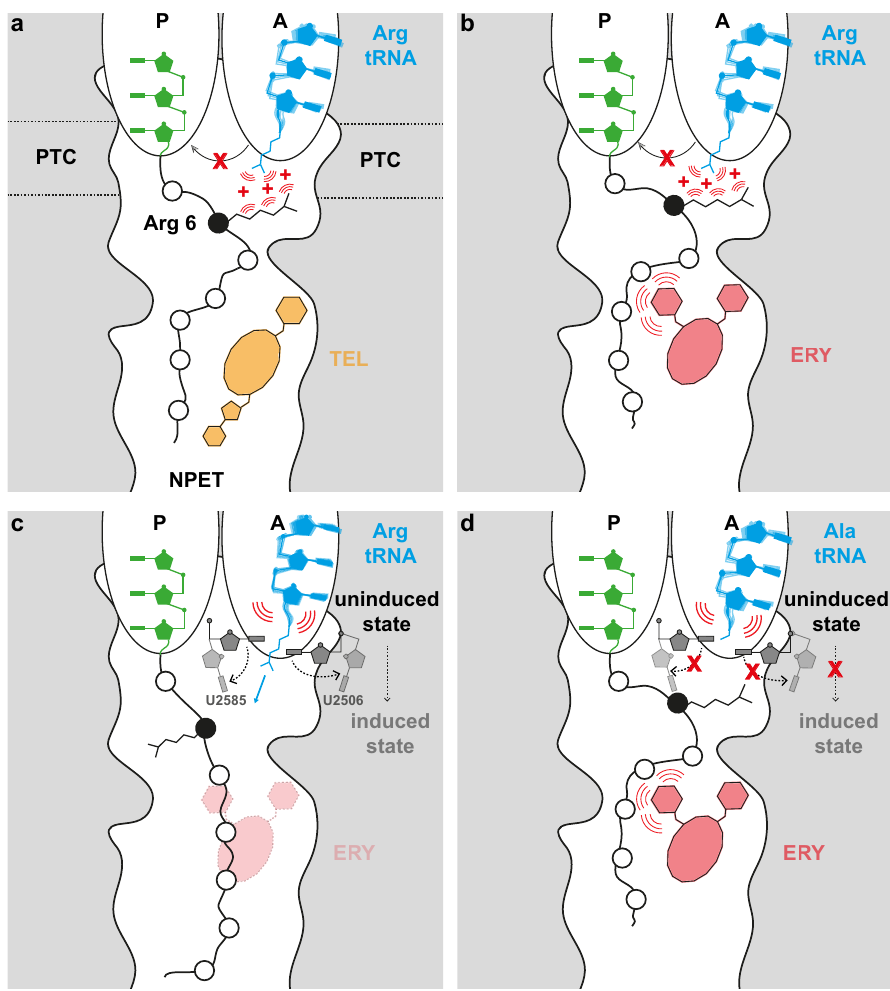
Fig. 7 Model for the ErmDL-mediated translation arrest in presence of TEL or ERY. a The presence of TEL in the tunnel restricts the space available for the ErmDL nascent chain, constraining the ErmDL Arg6 side chain to extend into the A-site and thereby preventing accommodation of the incoming Arg- tRNA via charge repulsion. b The presence of ERY with its cladinose ring further restricts the space available for the ErmDL nascent chain constraining the ErmDL Arg6 side chain to extend into the A-site preventing via a charge repulsion mechanism the incoming Arg-tRNA in the A-site to adopt a stable conformation. c In the absence of ERY, the ErmDL nascent chain freely explores the NPET and adopts an extended conformation. During the accommodation of an incoming A-tRNA, 23S residues U2506 and U2585 shift from their uninduced state to their induced state. d In the presence of ERY, the compacted conformation of ErmDL prevents the PTC from adopting the induced conformation necessary for accommodation of the A-site Ala-tRNA independently of the charge repulsion mechanism from c